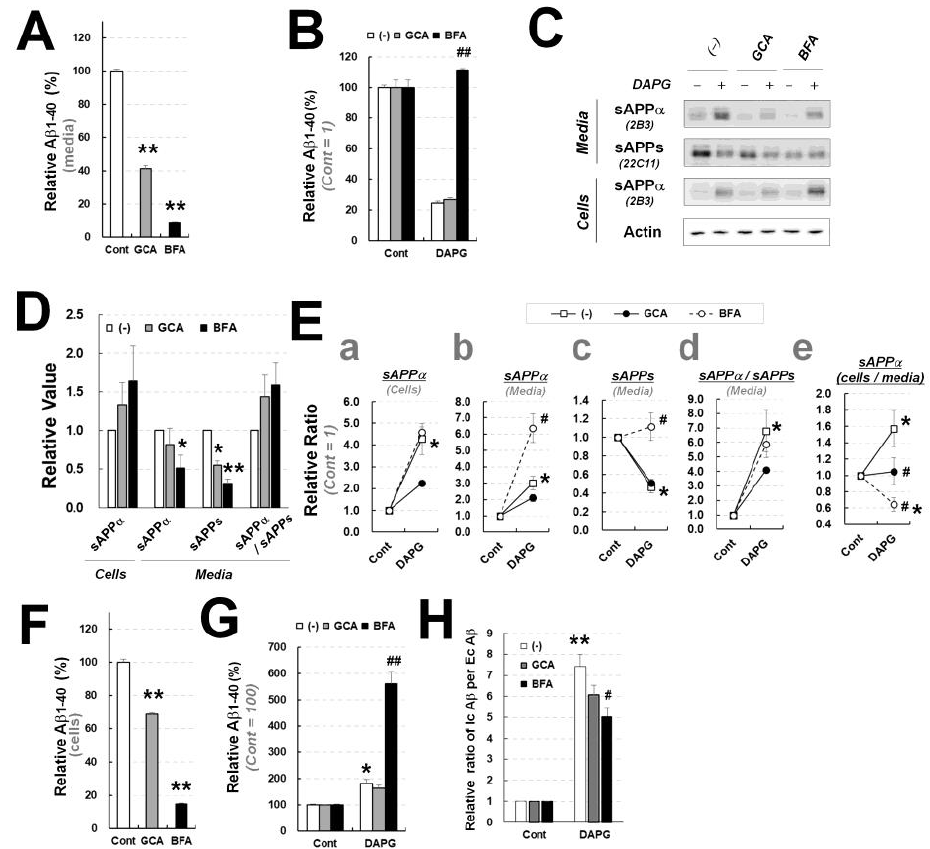
Figure 9. Examination of GCA and BFA effects in 293sw cells on DAPG-mediated A β levels decrease and sAPP α levels increase. ( A ) ELISA analysis of A β 1–40 amounts in the culture medium of 293sw cells treated with 3.5 µ M GCA or 60 ng/mL BFA for 8 h. ( B ) Relative A β 1–40 content in the culture medium of 293sw cells treated with 50 µ M DAPG with or without 3.5 µ M GCA or 60 ng/mL BFA for 8 h analyzed by ELISA. ( C ) Immunoblot analysis of sAPP α and sAPPs levels in 293sw cells treated with DAPG and GCA or BFA for 8 h. ( D , E ) Densitometry analysis of sAPP α and sAPPs levels in the medium or cells from immunoblots presented in ( C ). Panel D represents the effects of GCA or BFA alone. Panel E shows the relative ratio between controls and cells treated with DAPG alone (untreated) or with DAPG and GCA or BFA. The values of sAPP α levels in cells ( a ) and the medium ( b ) and sAPPs levels in the medium ( c ) as well as the ratios of sAPP α to sAPPs levels in the